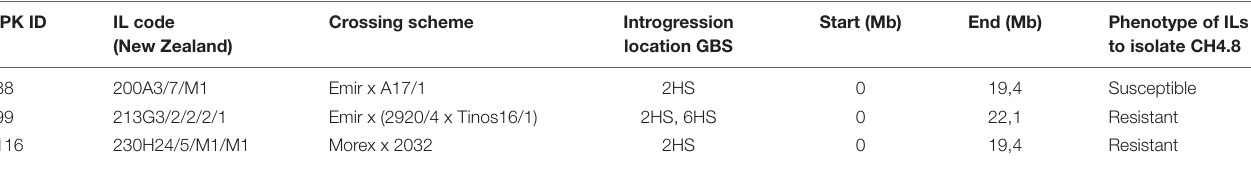
TABLE 1 | Hb introgression lines containing segments overlapping with IL “4176” and IL “5216” and their observed resistance phenotype to the Bgh isolate